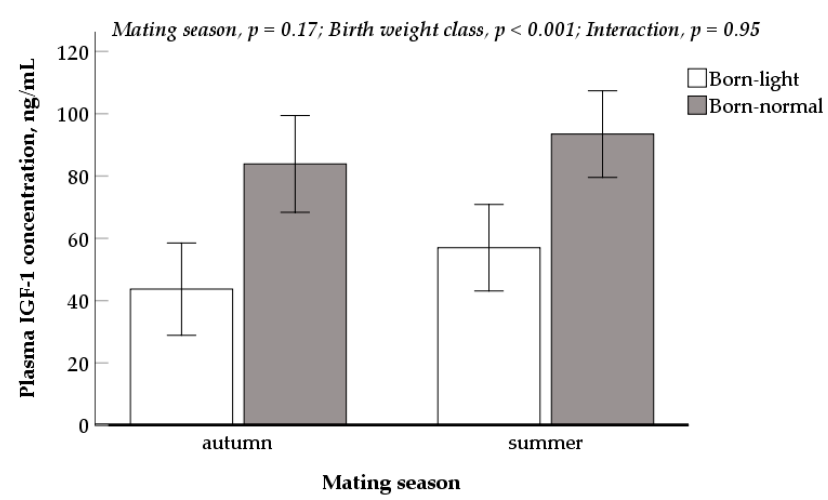
Figure 4. Plasma IGF-1 concentration (mean ± standard error) in newborn piglets from the sows mated in summer vs. autumn.